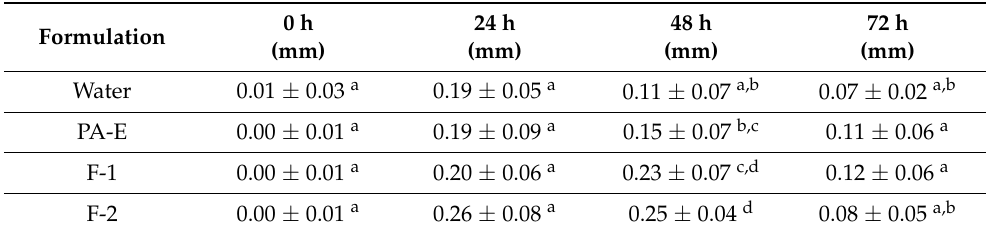
Table 4. Delayed-type hypersensitivity (DTH) test expressed as change in footpad thickness for each treatment measured at 0, 24, 48 and 72 h. 1